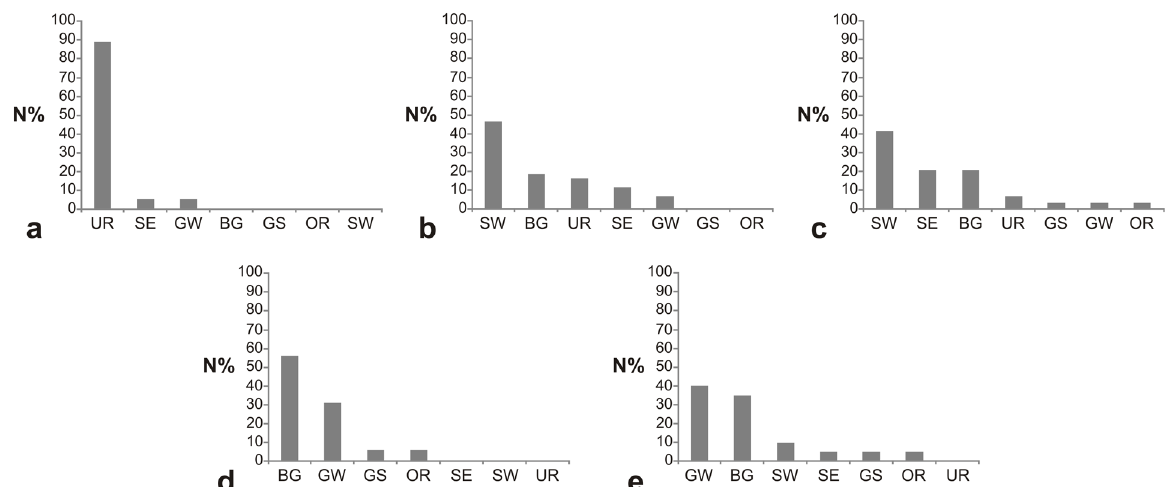
Figure 3. Microhabitats used by Epictia australis (a), Erythrolamprus poecilogyrus (b), Lygophis elegantissimus (c), Philodryas patagoniensis (d), and Bothrops alternatus (e). N% = percentage of specimens, SW = stream watercourse, SE = stream edges, GS = grassland with shrubs, GW = grassland without shrubs, BG = bare ground, OR = on top of rocks, UR = under